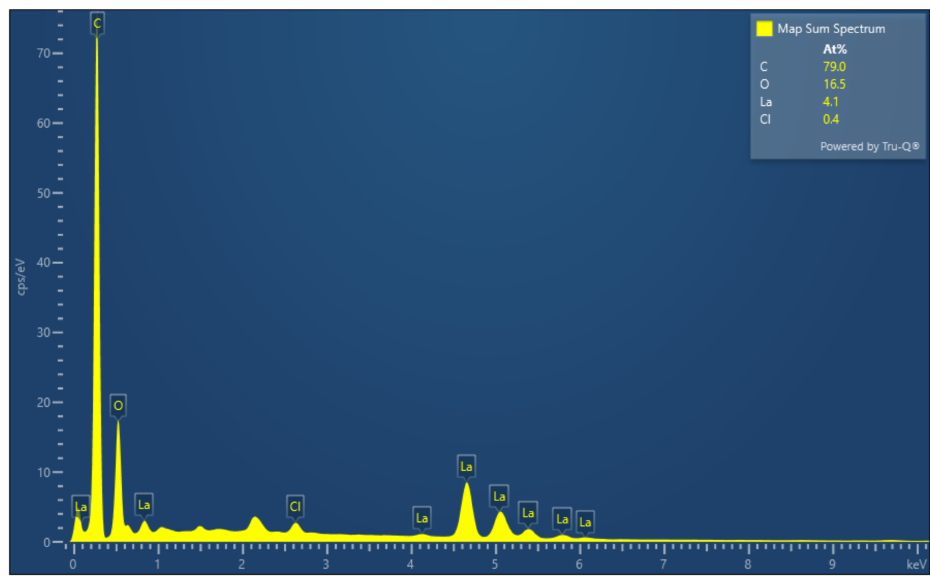
Figure 8. Element content diagram of lanthanum